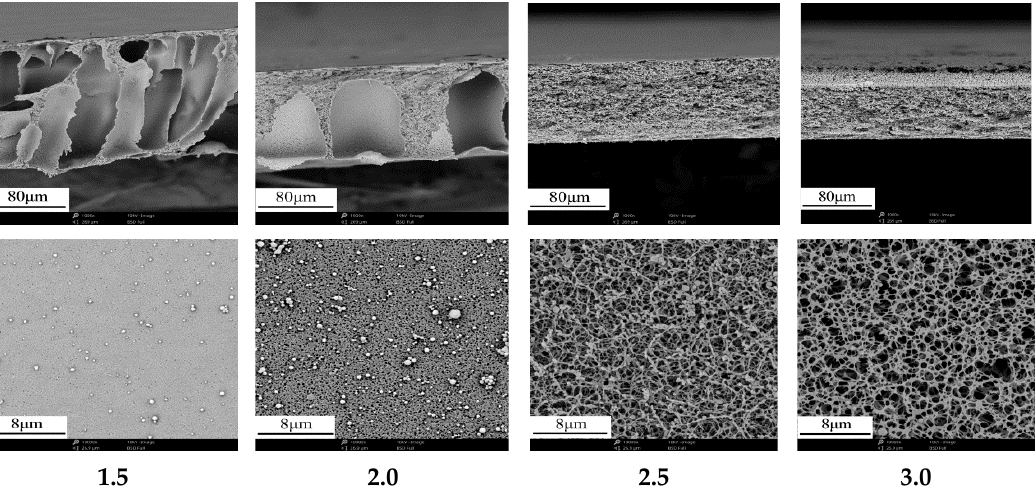
Figure 4. Effects of glycerol/CA ratio on the cross-section and surface microstructure of membranes. Table 5. The properties of membrane prepared under different glycerol/CA